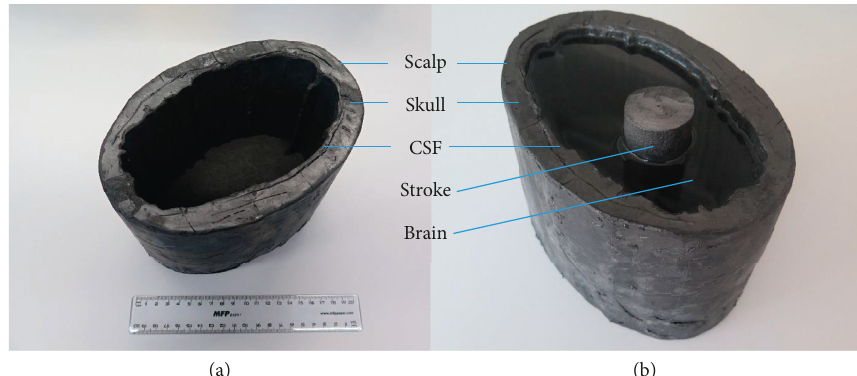
Figure 6: Photograph of the anatomically and dielectrically realistic 2.5D human head phantom: (a) external solid layers corresponding to scalp, skull, and CSF that are snugly attached to each forming a waterproof container; (b) fully assembled 5-layer human head phantom with added liquid brain phantom and a cylindrical solid stroke